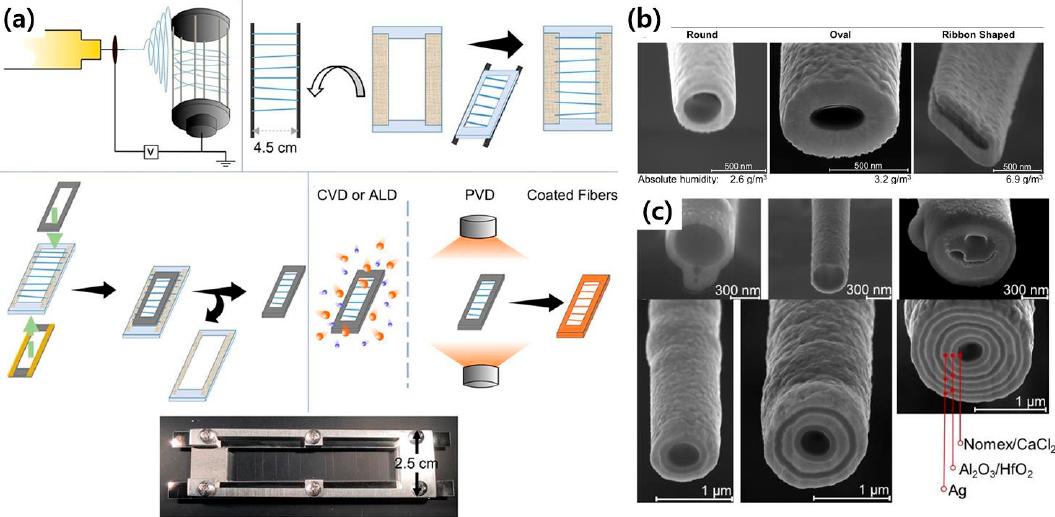
Figure 10. ( a ) Schematic illustration of the process for multi-layered fibrous structures, ( b ) cross-sectional SEM images of of poly( m -phenylene isophthalamide (PMIA) nanofibers with various cross-sectional structure by humidity control, and ( c ) layer-by-layer metal deposited PMIA nanofibers via atomic layer deposition (ALD) and chemical vapor deposition (CVD). [Adapted with permission from 91. Copyright (2019) American Chemical Society].